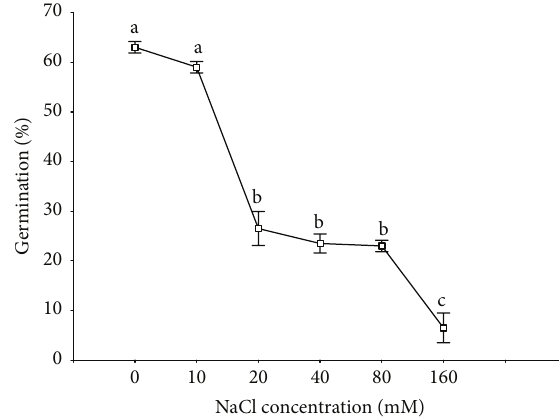
Figure 3: Effects of NaCl concentration on germination of Rumex confertus seeds ( 𝑛 = 4 ) incubated at 20 ∘ C with 12 h photoperiod for 20 days. Data points represent means from 4 replicates. Different letters indicate significant differences (ANOVA, Tukey’s test at 𝑃 < 0.05 ) in the germination percentages and rate of germination of seeds among different NaCl concentrations. Vertical bars represent standard deviations of the means.